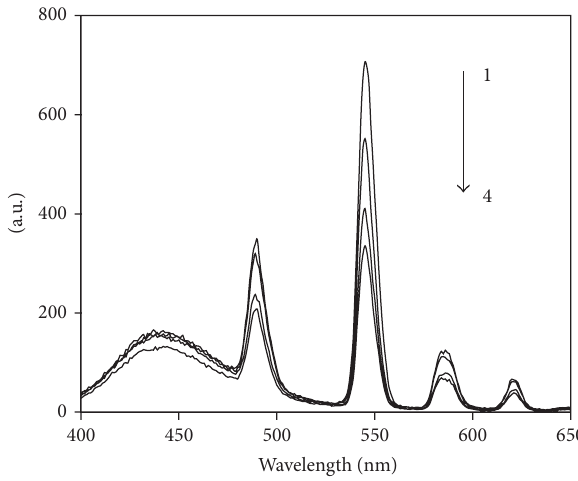
Figure 4: The fluorescence and second-order scattering spectra. (1) Silver nanoparticles-Tb(III)-PFLX (without filter), (2) silver nanoparticles-Tb(III)-PFLX (with filter), (3) Tb(III)-PFLX (without = 273 nm. Conditions: filter), and (4) Tb(III)-PFLX (with filter); 𝜆 ex silver nanoparticles, 5.0 × 10 −6 M; Tb(III), 2.0 × 10 −4 M; PFLX, 1.0 × 10 −6 M.